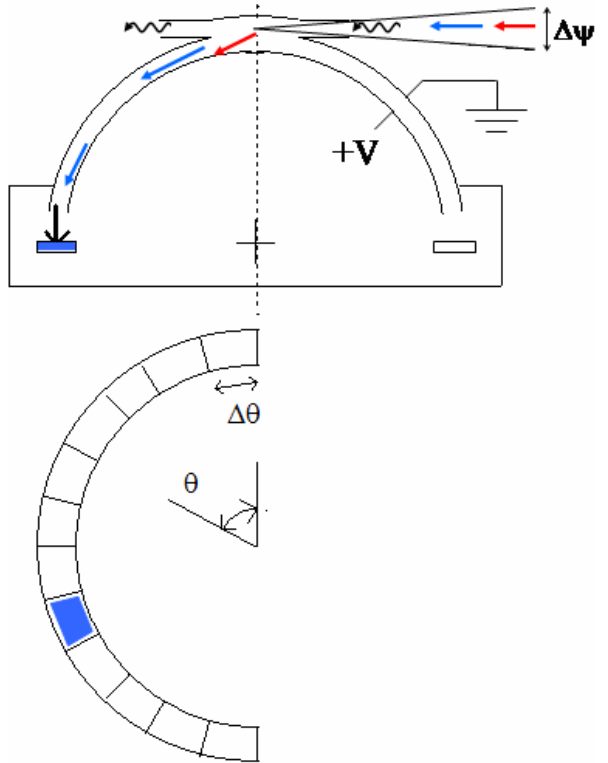
Fig. 1. Illustration of the principle of the Top Hat electrostatic anal- yser. The voltage applied to the analyser hemispheres diverts elec- trons (shown in blue) of a specific narrow band of energy and ar- Figure 1. Illustration of the principle of the Top Hat electrostatic analyser. The voltage riving within the acceptance angle 19 through the analyser to the applied to the analyser hemispheres diverts electrons (shown in blue) of a specific narrow detector, while electrons of other energies (e.g. in red) strike one of band of energy and arriving within the acceptance angle ∆Ψ through the analyser to the the analyser hemispheres and are not detected. The semi-annular detector, while electrons of other energies (e.g. in red) strike one of the analyser microchannel plate amplifies the signal of an electron reaching it, hemispheres and are not detected. The semi-annular microchannel plate amplifies the and the resulting charge cloud is detected by one of 12 segments signal of an electron reaching it, and the resulting charge cloud is detected by one of 12 of the anode beneath, giving information about the electron arrival direction θ . The Top Hat design is able to provide a focussed spot in the detector plane for a parallel electron beam arriving from any- where in the aperture plane. At times when the aperture looks sun- ward, the majority of photons (black wiggly arrow) pass through the aperture and do not find their way to the detector.